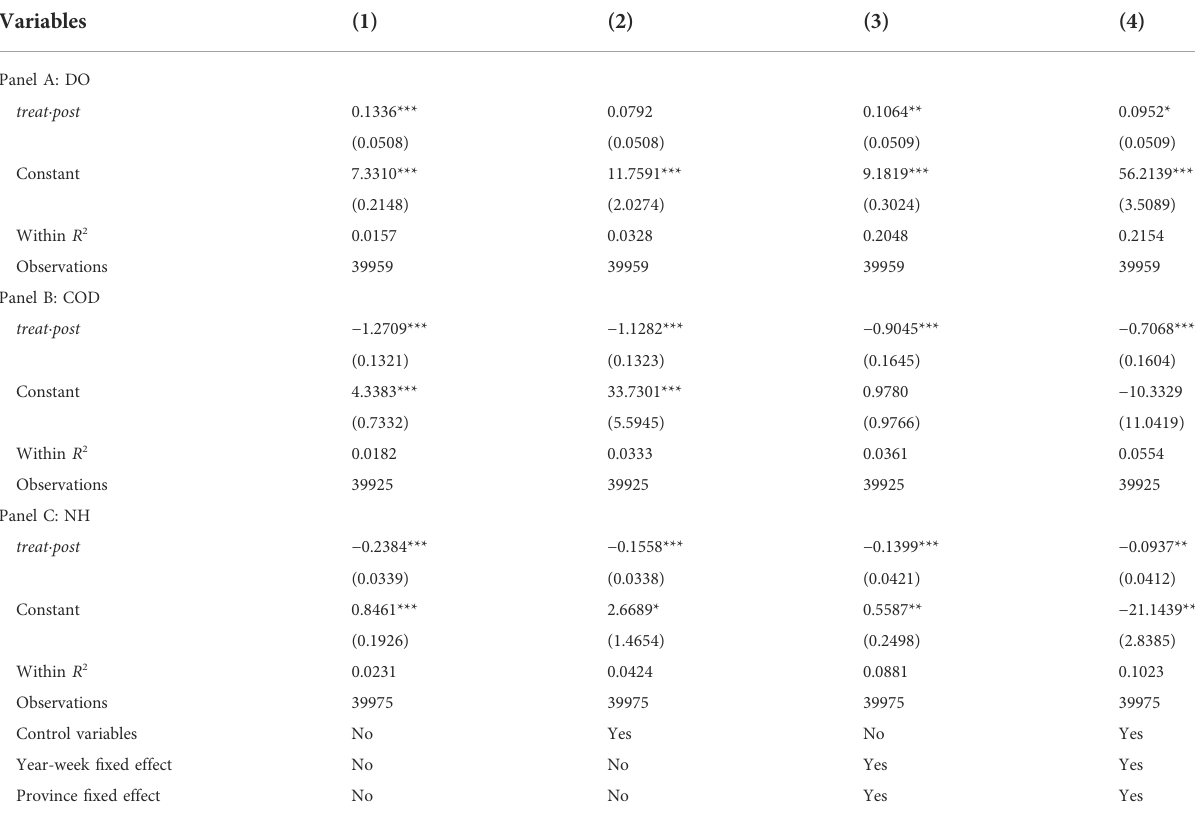
TABLE 2 Regression results of the policy on the impact of transboundary water pollution in China ’ s river